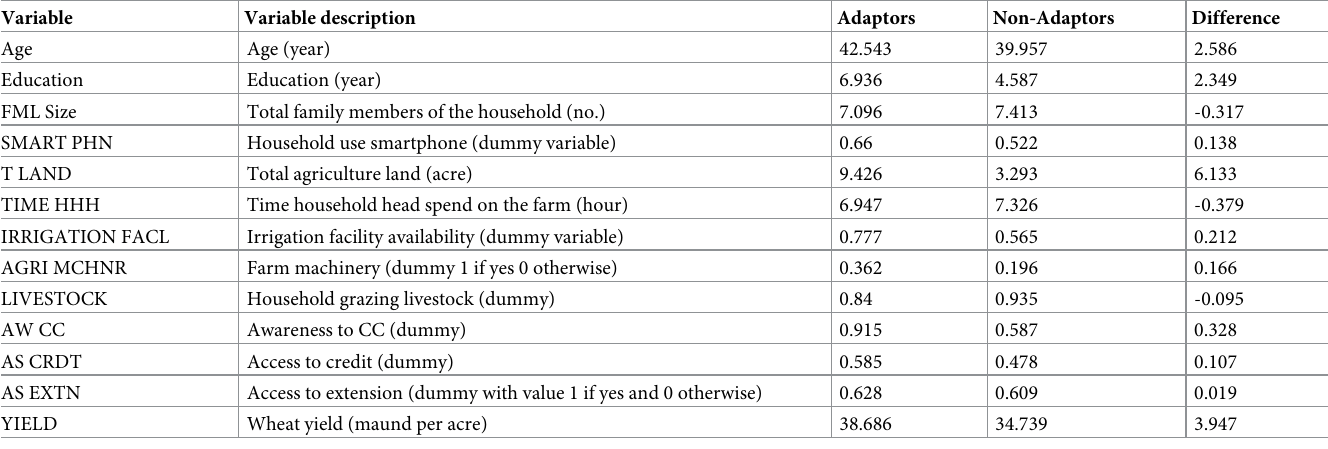
Table 4. Mean difference between adapters and